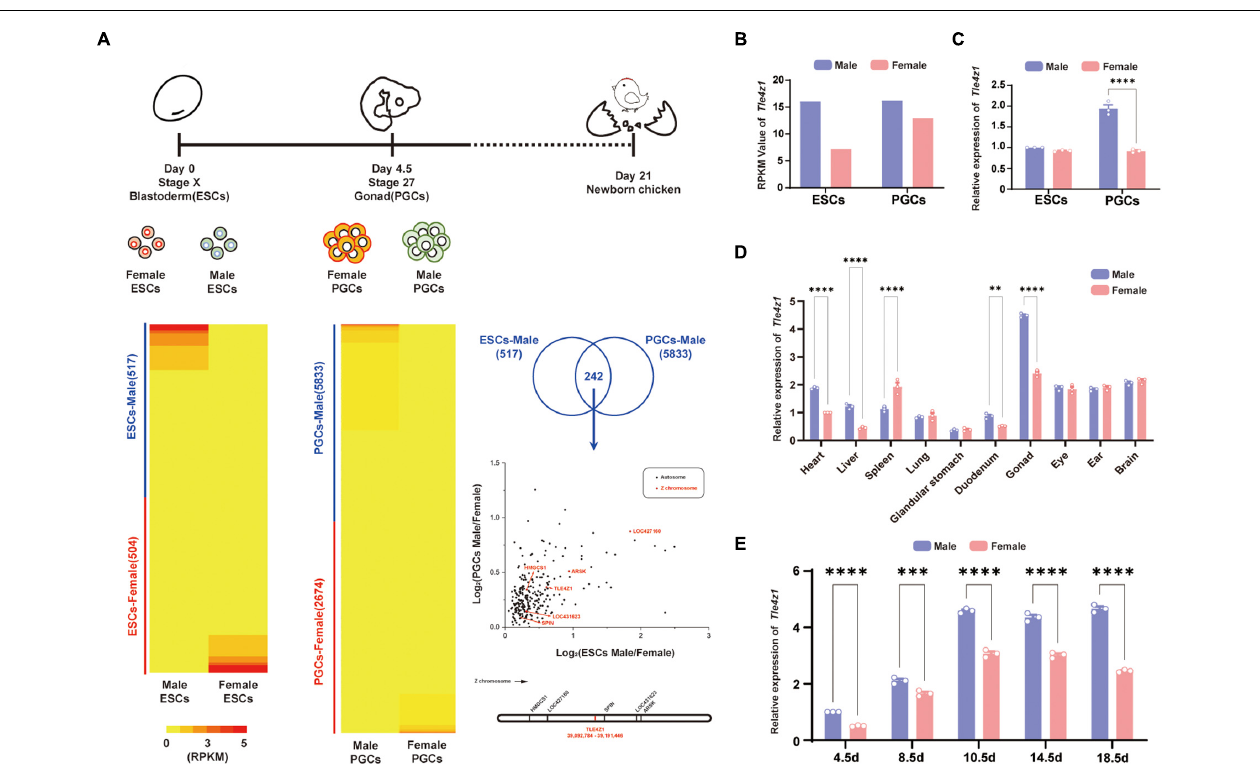
FIGURE 1 | The sexually dimorphic expression of Tle4z1 in cells and tissues of chicken. (A) Experimental design of RNA-seq analysis (top). RPKM of differentially expressed genes(DEGs) in ESCs and PGCs of different genders (left bottom). Filter out male-specific high expression genes of Z chromosome (right). Venn analysis screened out 242 DEGs shared in male PGCs and ESCs. Volcano plot where the x-axis represents the level of differential expression of PGCs and the y-axis shows significant differences in expression of ESCs in both sexes. Genes in Z chromosome are indicated by red dots, and autosome chromosome genes are indicated by black dots. The diagram marks the locations of six male highly-expressed genes (right bottom). (B) RPKM of Tle4z1 in ESCs and PGCs of different genders. (C) Validation of mRNA expression of Tle4z1 by qRT-PCR. The expression of Tle4z1 in male ESCs was defined as 1 after normalization to β -actin. (D) Relative expression of Tle4z1 in adult chicken tissues as measured by qRT-PCR. (E) Relative expression of Tle4z1 during the development of chicken embryos by extraction of RNA from gonads at different stages (E4.5-E18.5). ∗∗ P < 0.01, ∗∗∗ P < 0.001, ∗∗∗∗ P < 0.0001. All values are mean ± SEM. n =